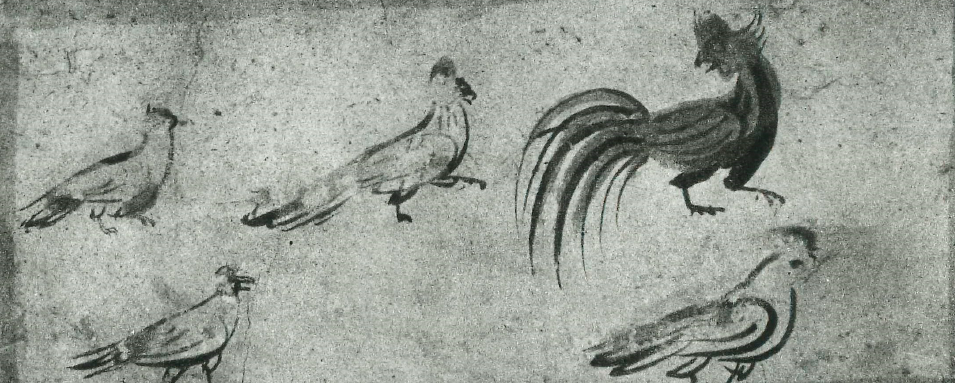
Figure 5. Rooster and hens, west wall of front chamber, Xincheng M3, painting on brick, Wei-Jin period (220–317). (Gansusheng Bowuguan et al. 1985, pl. 54.3). ©Wenwu Press. This figure published with permission of Wenwu Press and cannot be used or copied without their